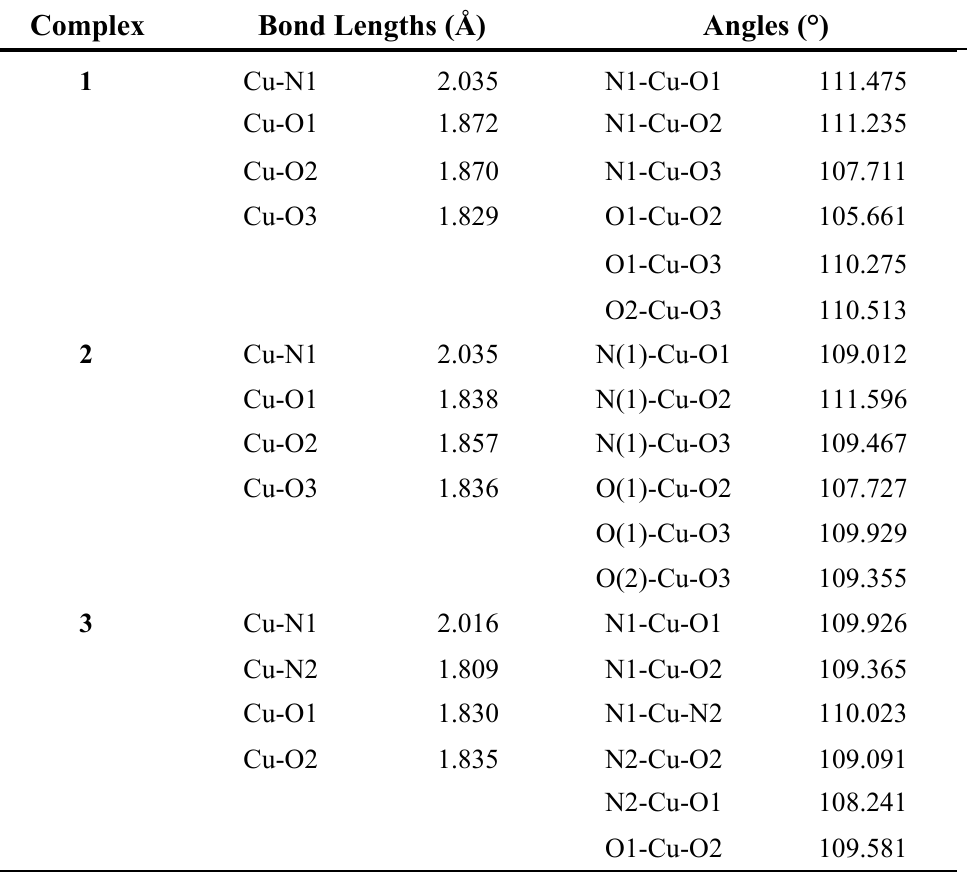
Table 7. Selected bond distances (Å) and angles (°) of complexes 1-3